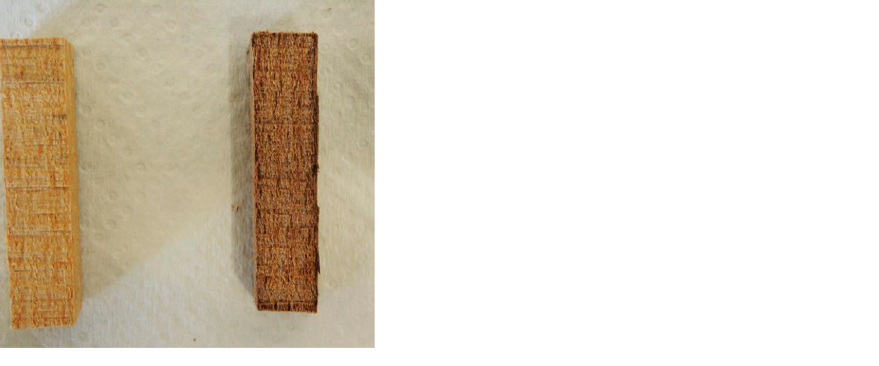
Figure 3. Color change of model samples after solvent extraction: left—acetone, right—acetone with sulfuric acid.